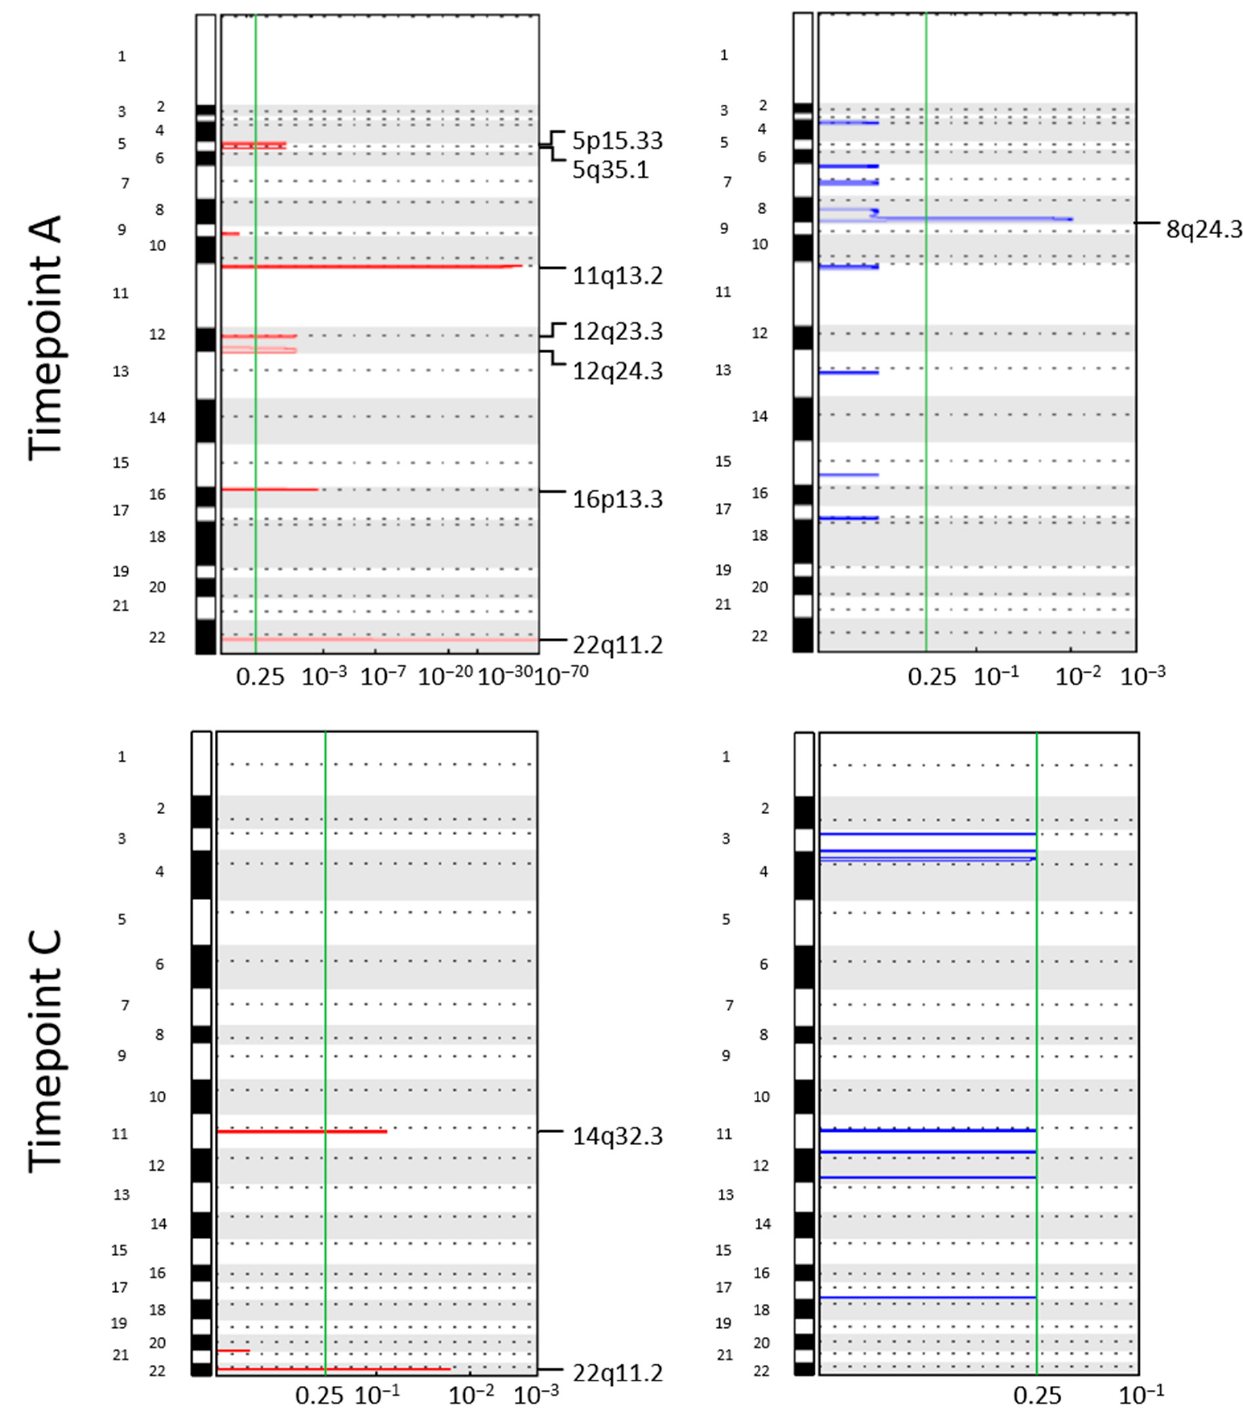
Figure 3. Genomic Identification of Significant Targets in Cancer (GISTIC) amplification and deletion plots on single circulating tumor cells (CTCs) from patient CH30. Each column represents a different timepoint. The genome is oriented vertically from top to bottom, and the GISTIC q -values at each locus are plotted from left to right on a log scale. The green line represents the significance threshold ( q -value = 0.25). A: basal (37 CTCs); C: end of therapy (2